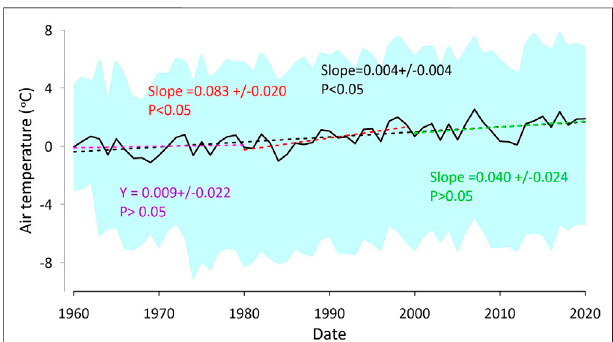
FIGURE 2 | MAAT with the trend from 1960 to 2020 based on 30 stations across Mongolia. The plot includes the range of MAAT (cyan, shaded), the linear trend from 1960 to 1980 (purple dash line), the linear trend from 1981 to 2000 (red dash line), the linear trend from 2001 to 2020 (green dash line), and thelinear trend from 1960to2020 (black dash line). The statistic information is related to the same-coloured